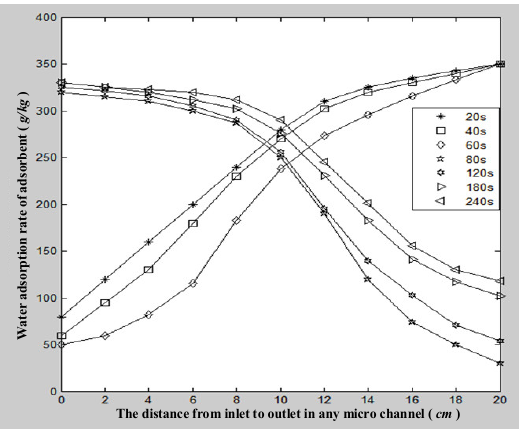
Figure 8. Variation in sorbent moisture adsorption rate at various points along the channel direction.